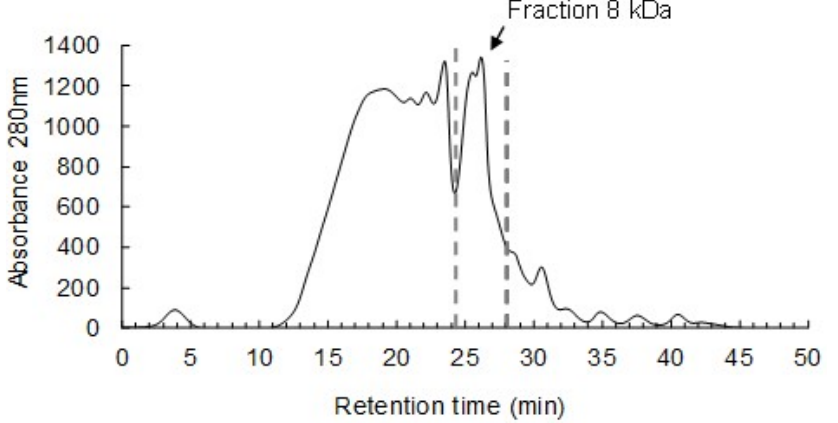
Figure 1. Gel filtration chromatographic profile of the 2–10 kDa peptidic fraction of the 7 ‐ day old supernatant from S. cerevisiae ER